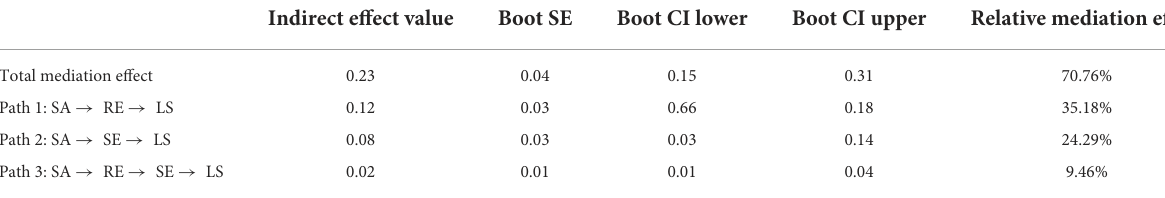
TABLE 3 Bootstrap analysis of the mediating effect of resilience and self-esteem between subjective age and